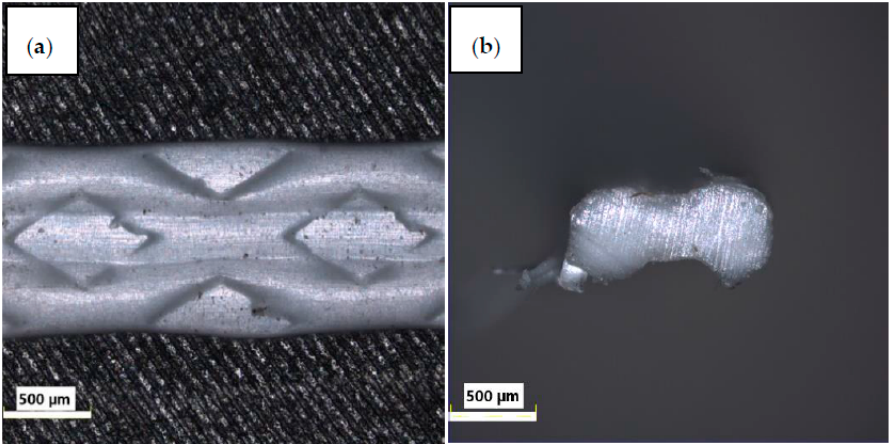
Figure 7. Light microscope images of PPW (Olympus): ( a ) surface, ( b ) cross-section [55].